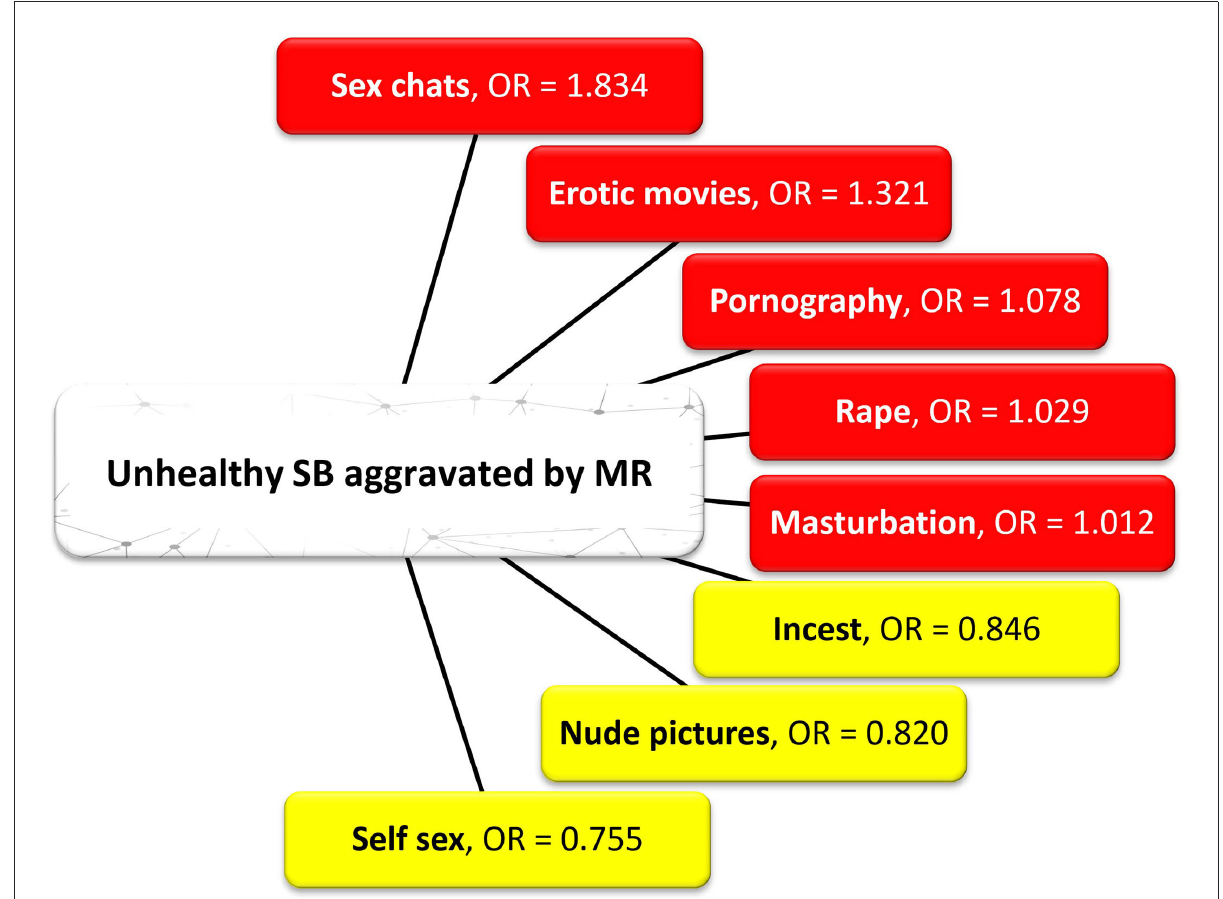
FIGURE2 Unhealthy SB aggravated by the COVID-19 lockdown. According to the odds ratio (OR), the red-colored variables have a higher likelihood of occurrence vs. the yellow-colored variables which have a lower likelihood of occurrence.